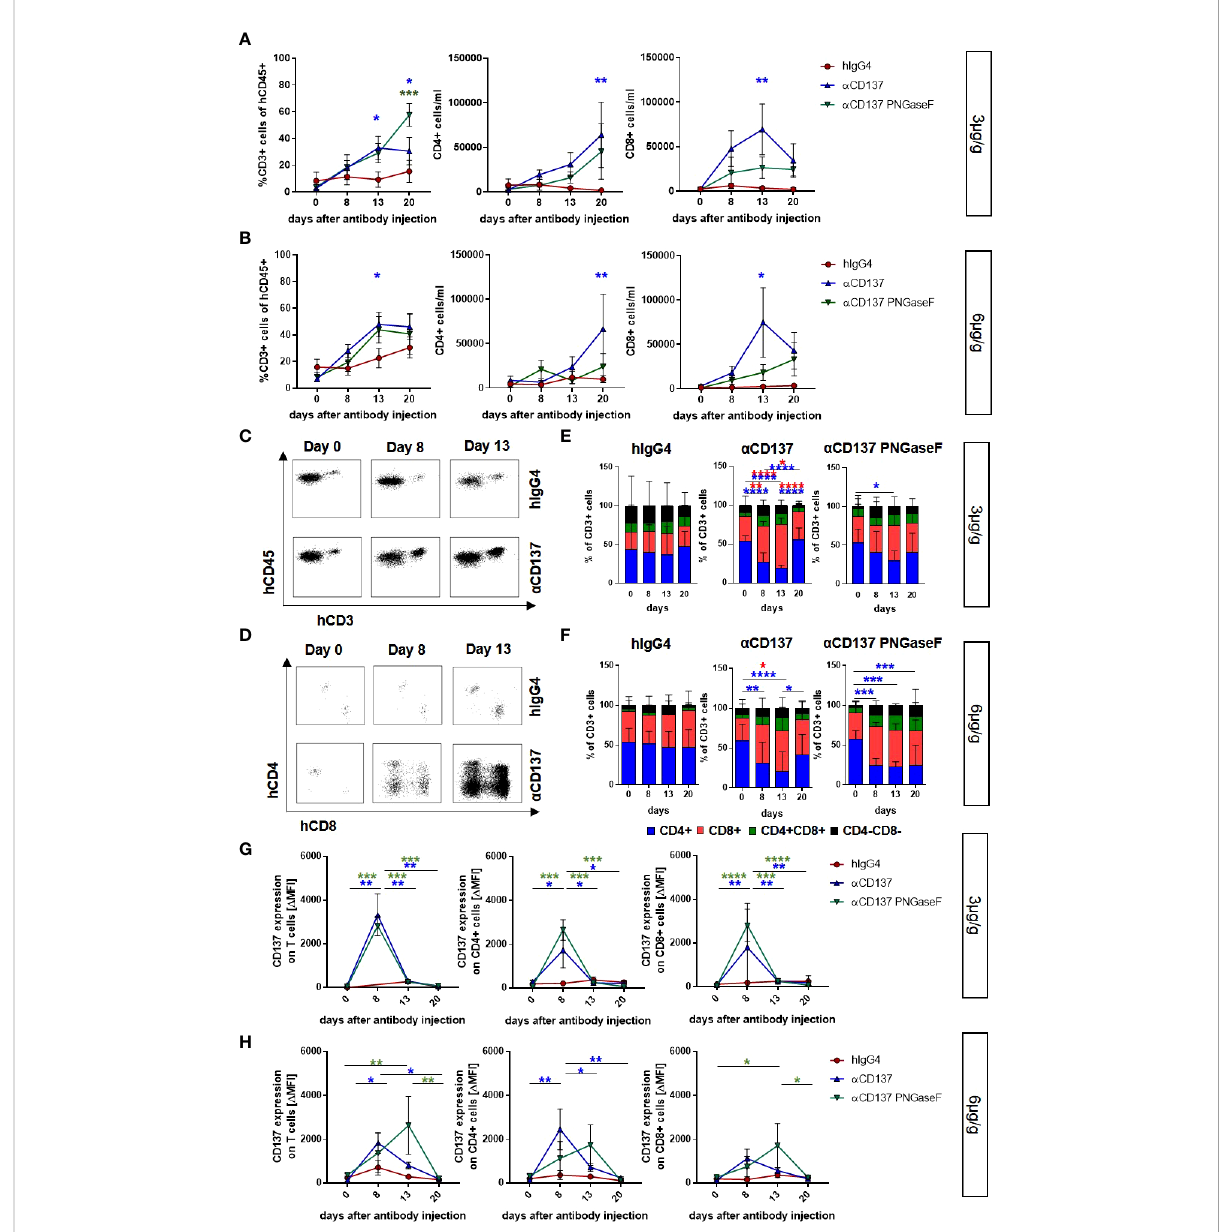
FIGURE 2 Impact of urelumab antibody dose and glycosylation on human T cells in the peripheral blood of humanized mice. Humanized mice received either 3 or 6µg/g of a human IgG4 isotype control, urelumab ( a CD137) or deglycosylated urelumab ( a CD137 PNGaseF) and were studied for the next twenty days after antibody injection. (A, B) Shown are the relative amounts of human CD3+ T cells (% of human CD45+ cells) and the absolute numbers of CD4+ or CD8+ T cells per ml blood of mice treated with 3µg/g (hIgG4: n= 5; a CD137: n=6; a CD137 PNGaseF: n=4) (A) or 6µg/g (hIgG4: n= 7-13; a CD137: n=10-11; a CD137 PNGaseF: n=6) (B) of the indicated antibody preparations. Coloured asterisks matching the respective colouring of the treatment group indicate signi fi cant differences at the indicated time-point of this group compared to the hIgG4 isotype control group. (C-F) Representative dot plots demonstrating the expansion of human CD3+ T cells (C) or CD4+ and CD8+ T cell subsets (D) in the peripheral blood of humanized mice before and at 8 or 13 days after injection of 6µg/g of the respective IgG4 antibodies; and quanti fi cation (E, F) of the relative abundance of human T cell subsets in mice receiving 3µg/g (hIgG4: n=6; a CD137: n=6 a CD137 PNGaseF: n=4) (E) or 6µg/g (hIgG4: n=11; a CD137: n=11 a CD137 PNGaseF: n=5) of the speci fi ed antibodies (F) at the indicated time points after injection. (G, H) CD137 expression (mean D MFI) on CD3+ (left panel), CD4+ (middle panel) and CD8+ (right panel) T cells in mice treated with 3µg/g (G) (hIgG4 n= 3; a CD137: n=6; a CD137 PNGaseF: n=4) or with 6µg/g (H) (hIgG4: n=7; a CD137: n=6-7; a CD137 PNGaseF: n=4-6) of the respective antibody preparations. Shown are pooled data from two to three independent experiments. Results are presented as mean +/-SEM. For statistical analysis 2-Way Anova with Tukey ’ s multiple comparison test was used to assess signi fi cant differences between experimental groups. *p<0.05; **p<0.01; ***p<0.001;